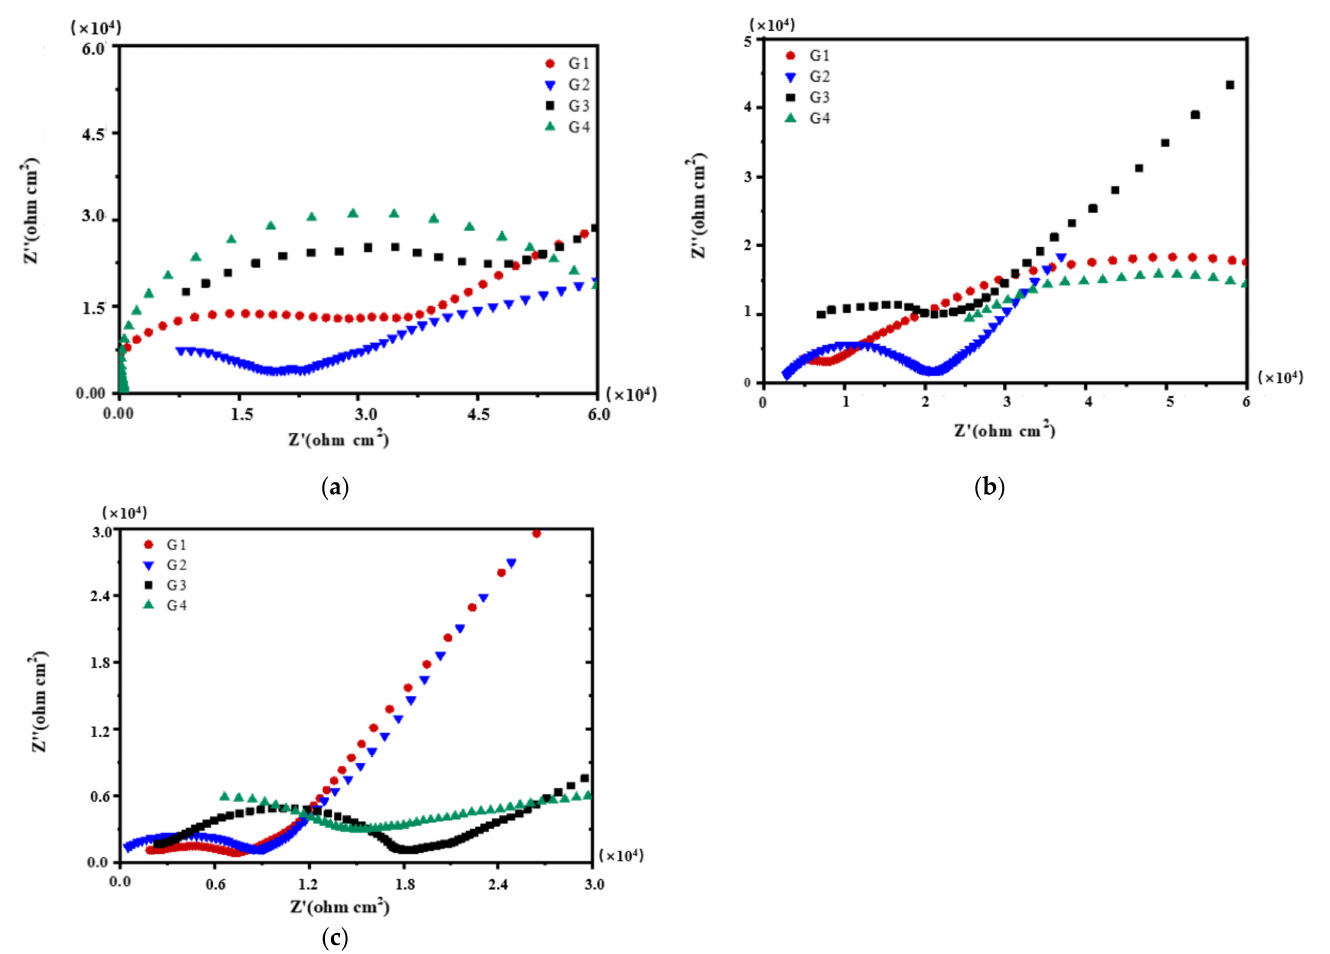
Figure 6. Each coating’s Nyquist pattern for immersion for 45 days: ( a ) 20% Seawater; ( b ) 40% Seawater; ( c ) 60% Seawater.